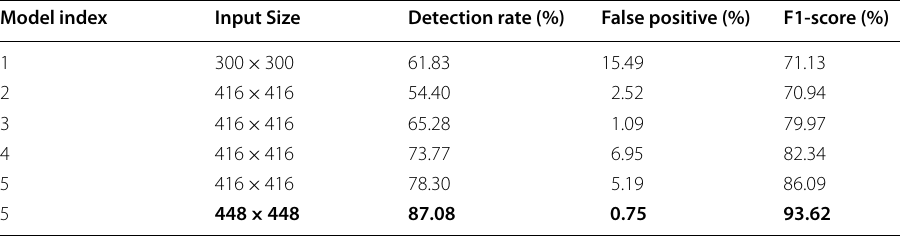
Bold indicates better results